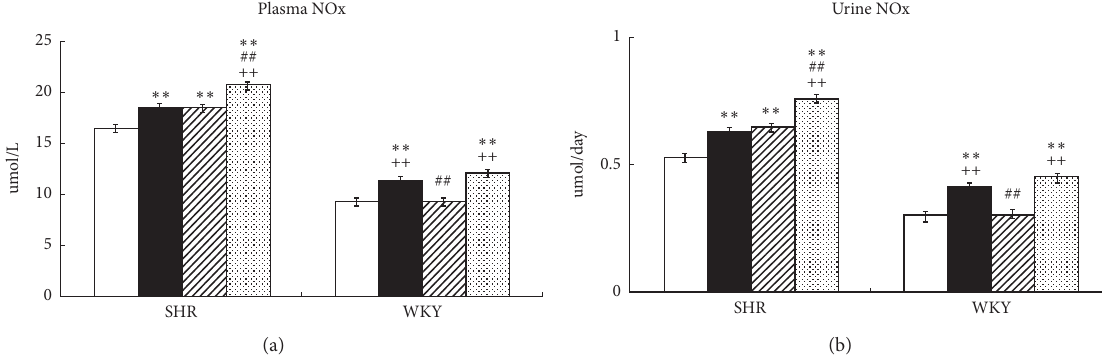
Figure 2: Effects of Ex and tempol on plasma and urinary NOx in SHR and WKY. The NOx in plasma (a) and urine (b) of SHR and WKY was compared among the control group (open bars), Ex group (closed bars), Tmp group (hatched bars), and Ex +Tmp group (checked bars) ( n � 10 in each group). ∗ P < 0 . 05 vs. the control group. ∗∗ P < 0 . 01 vs. the control group. ## P < 0 . 01 vs. the Ex group. ++ P < 0 . 01 vs. the Tmp group.